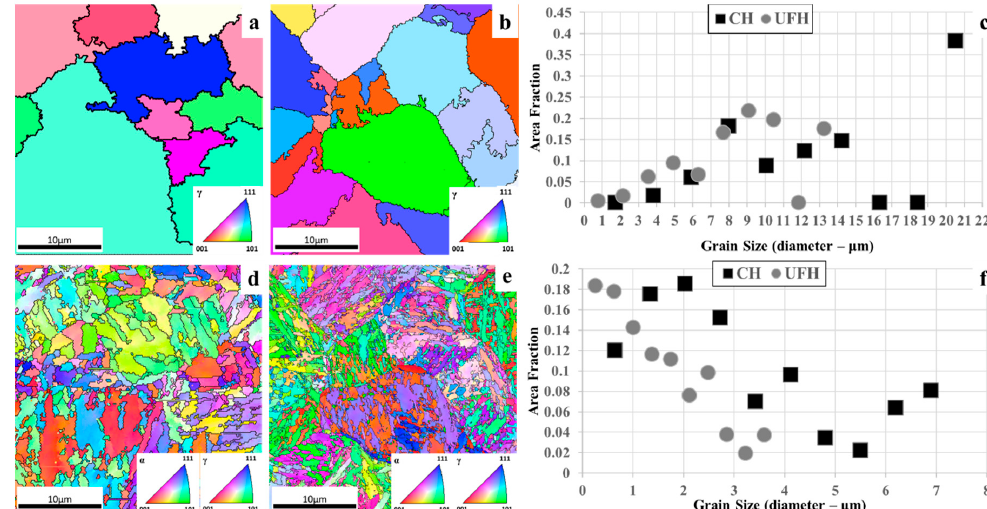
Figure 4. ( a ) IPF map of the reconstructed PAGs of the CH sample with the use of the ARPGE [46] software, ( b ) IPF map of the reconstructed PAGs of the UFH sample with the use of the ARPGE [46] software, ( c ) grain size chart for the PAGs of both samples indicating the refinement of austenite in UFH, ( d ) IPF map of the final microstructure of the CH sample, ( e ) IPF map of the final microstructure of the UFH sample, ( f ) grain size chart for the final microstructure of both samples indicating the refinement of grains and laths in the UFH.